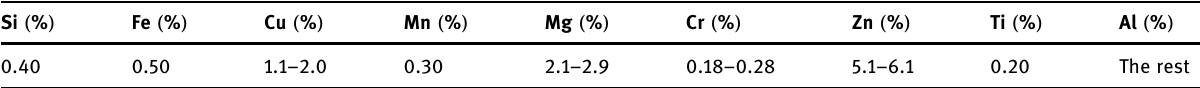
Table 1: Material composition of 7075 - T6 Al alloy